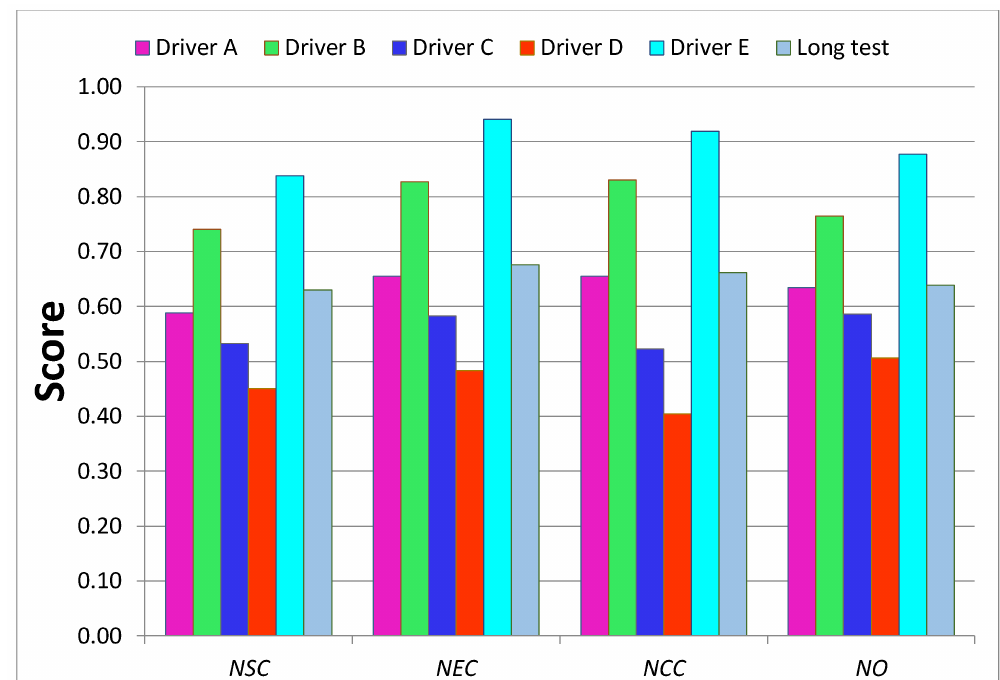
Figure 14. Bar graph of normalized criterion scores from the test rides, where ‘1’ is the expert